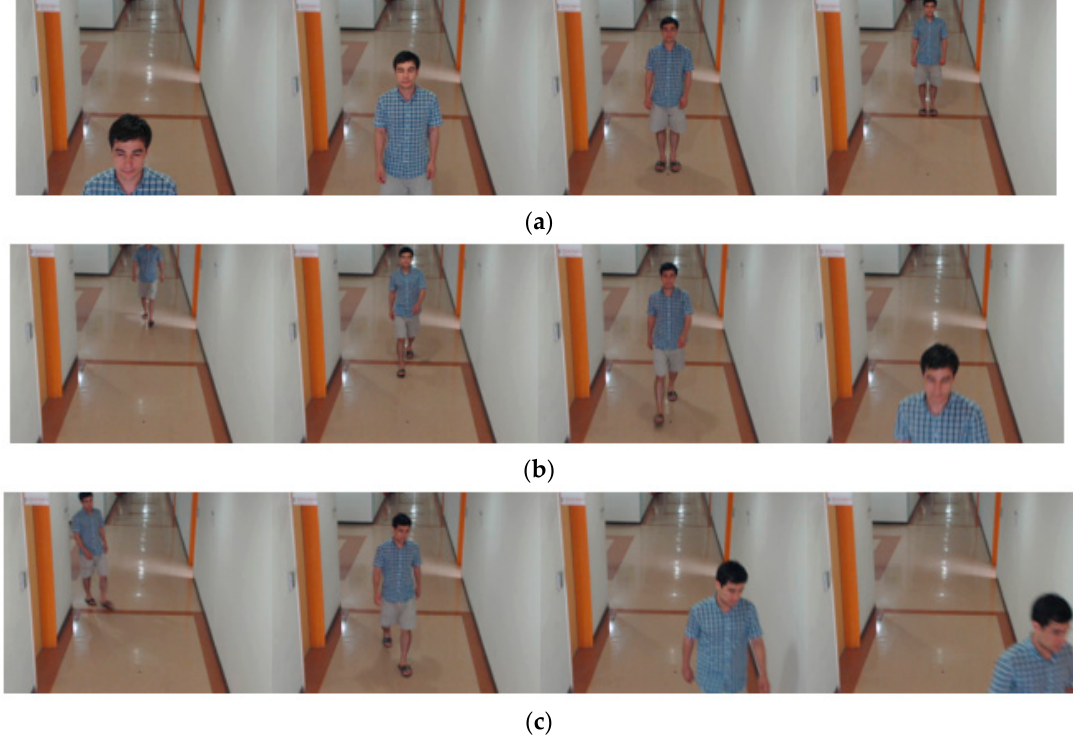
Figure 9. Example images from DFB-DB1 taken by the Logitech BCC 950 camera. ( a ) One-person still image. ( b ) One-person straight-line movement image. ( c ) One-person corner movement image.